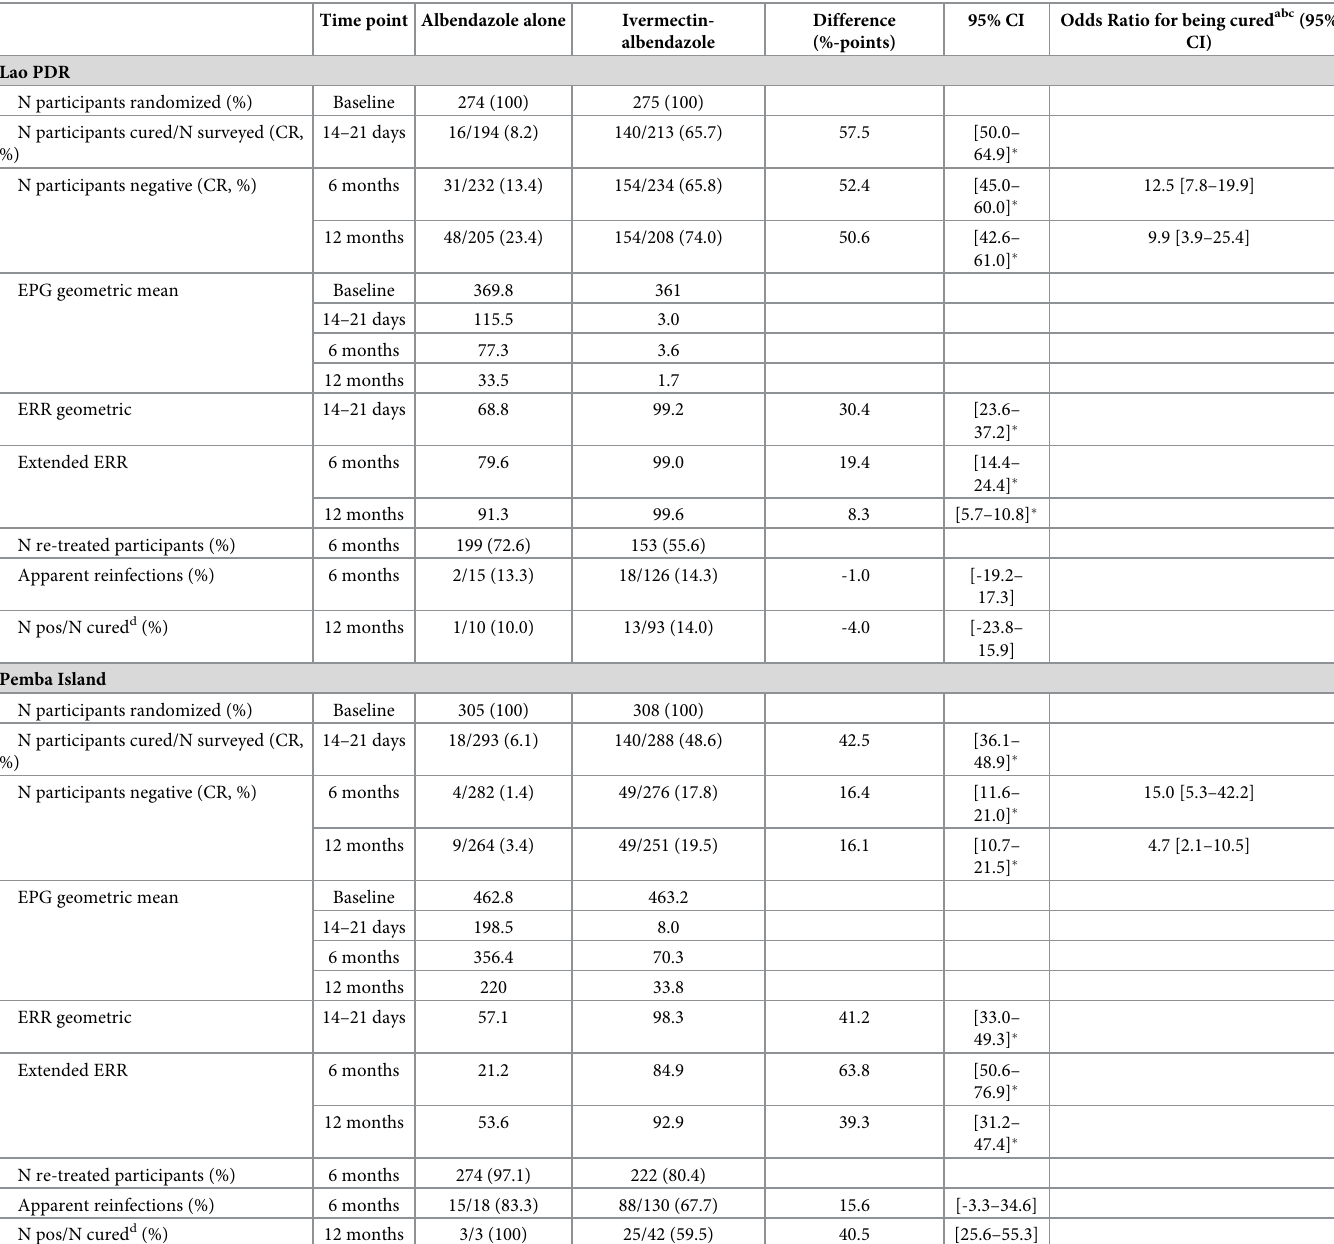
Table 2. Short and long-term outcomes and reinfection data for ivermectin-albendazole and albendazole alone against T . trichiura in Lao PDR and Pemba Island. Time point Albendazole